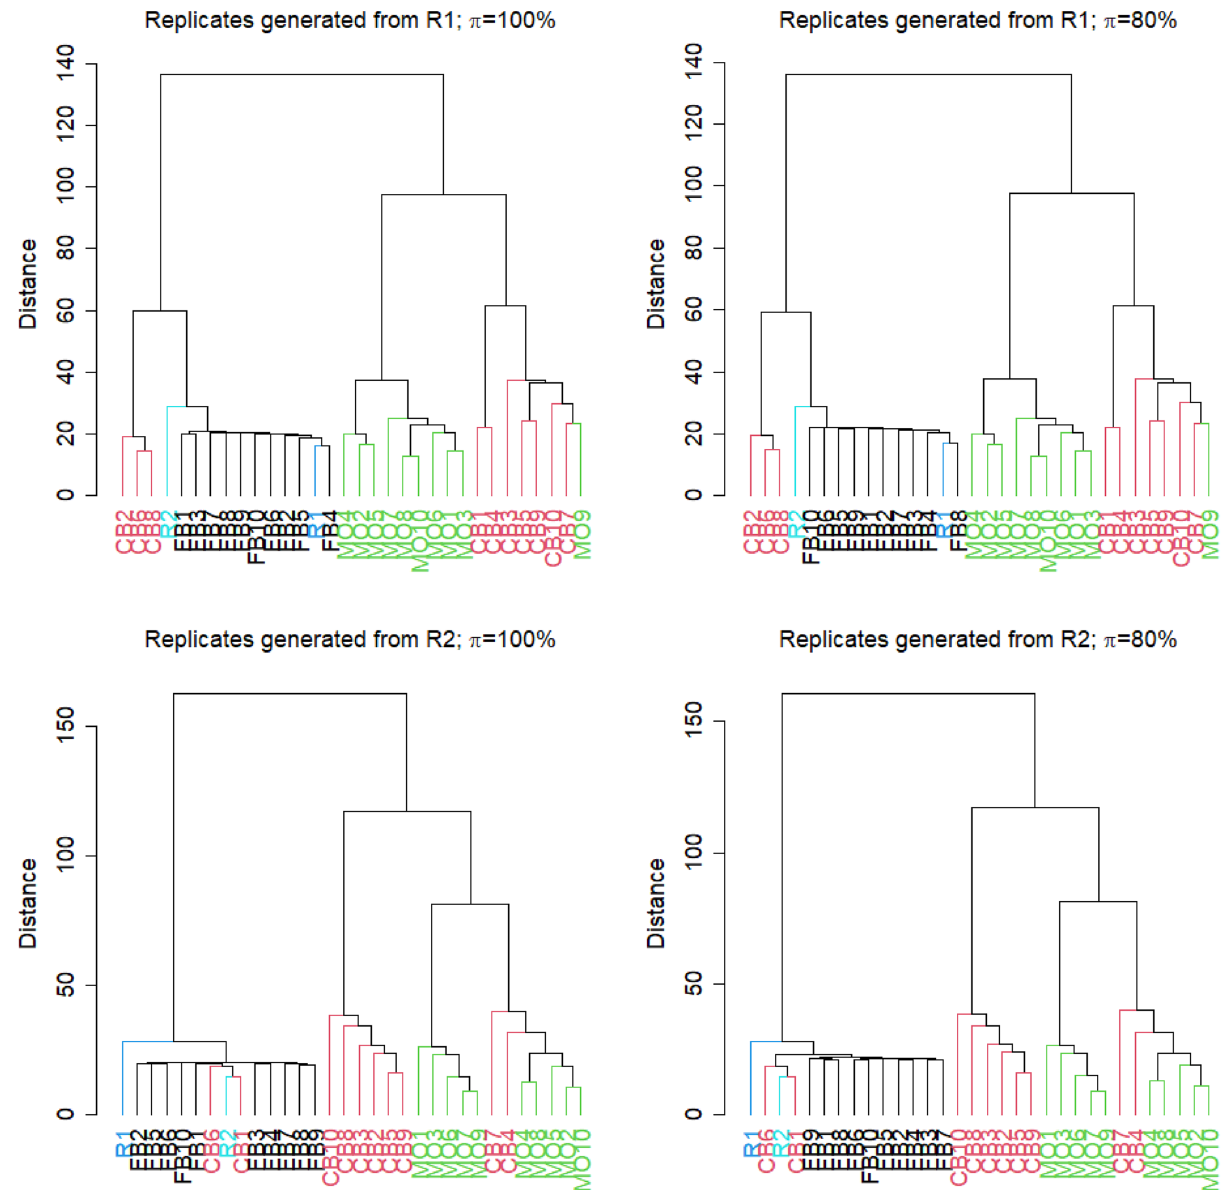
Figure 3. Cluster trees of it p value lists, where similarity of it p value lists was specified using Spearman’s correlation coefficient ρ . R1 and R2 denote the it p value lists obtained from the differential expression analysis of the original two replicates. FB1 to FB10 are the it p value lists from the approach of generating technical replicates by boostrapping reads from FASTQ-files. CB1 to CB10 denote the results after column boostrap and MO1 to MO10 denote the results obtained by the mixing observation approach. Cluster trees were generated either when artificial replicates were generated from R1 (top) or from R2 (bottom). Furthermore, FB replicates were either sampled with π = 100% or π = 80% of reads from the original on the basis of data from R1 (Fig. 3, top) or from R2 (Fig. 3, bottom). Furthermore, results for the FB approach are either based on values of π =100% or π =80%. As detailed above, π denotes the percentage of reads sampled relative to the original amount of reads in a FASTQ-file. When generating FB results from R1, one can observe that the distance between results generated by the FB approach are closer to the results of the true experimental replicates R1 and R2 than results from the CB and MO approaches. When generating artificial replicates from R2 there are two results from the CB method that are as close to R1 and R2 as the FB results. Independent of generating results from R1 and R2, the results obtained from the MO approach and the majority from the CB approach clustered as outgroups. There is nearly identical clustering when changing the value of π . However, in regard of the desired aim, FB results are always too close to the original replicate from which artificial replicates were generated.